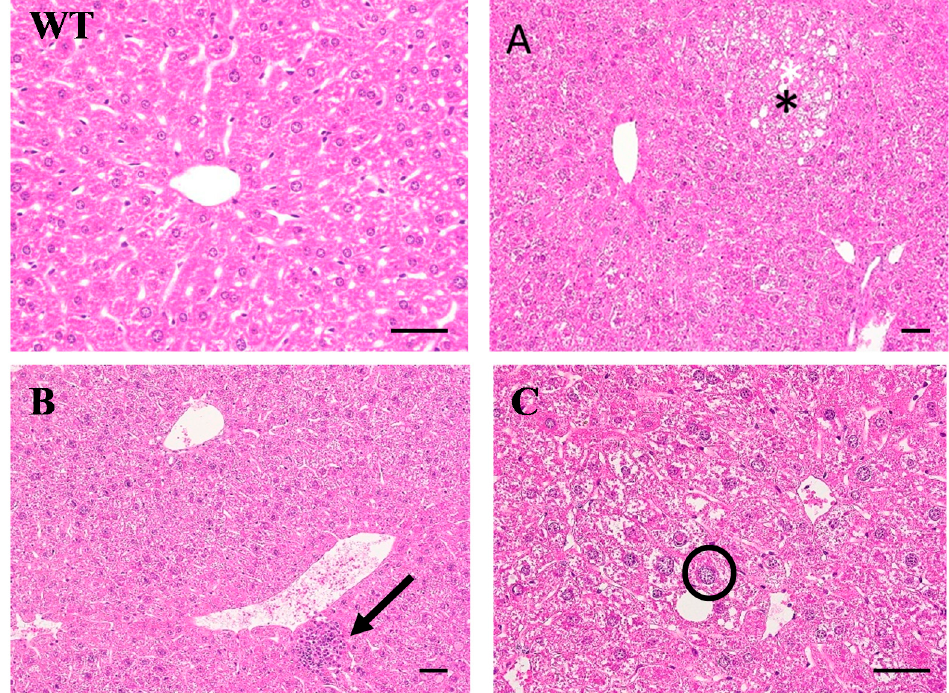
Figure 2. Hematoxylin and eosin staining histopathological examination of the livers from WT and HBx mice. ( A ) Focus of hepatocellular alteration (Clear cell foci); ( B ) inflammatory cell infiltration; ( C ) hepatocellular hypertrophy. The scale bars indicate 30 μ m.